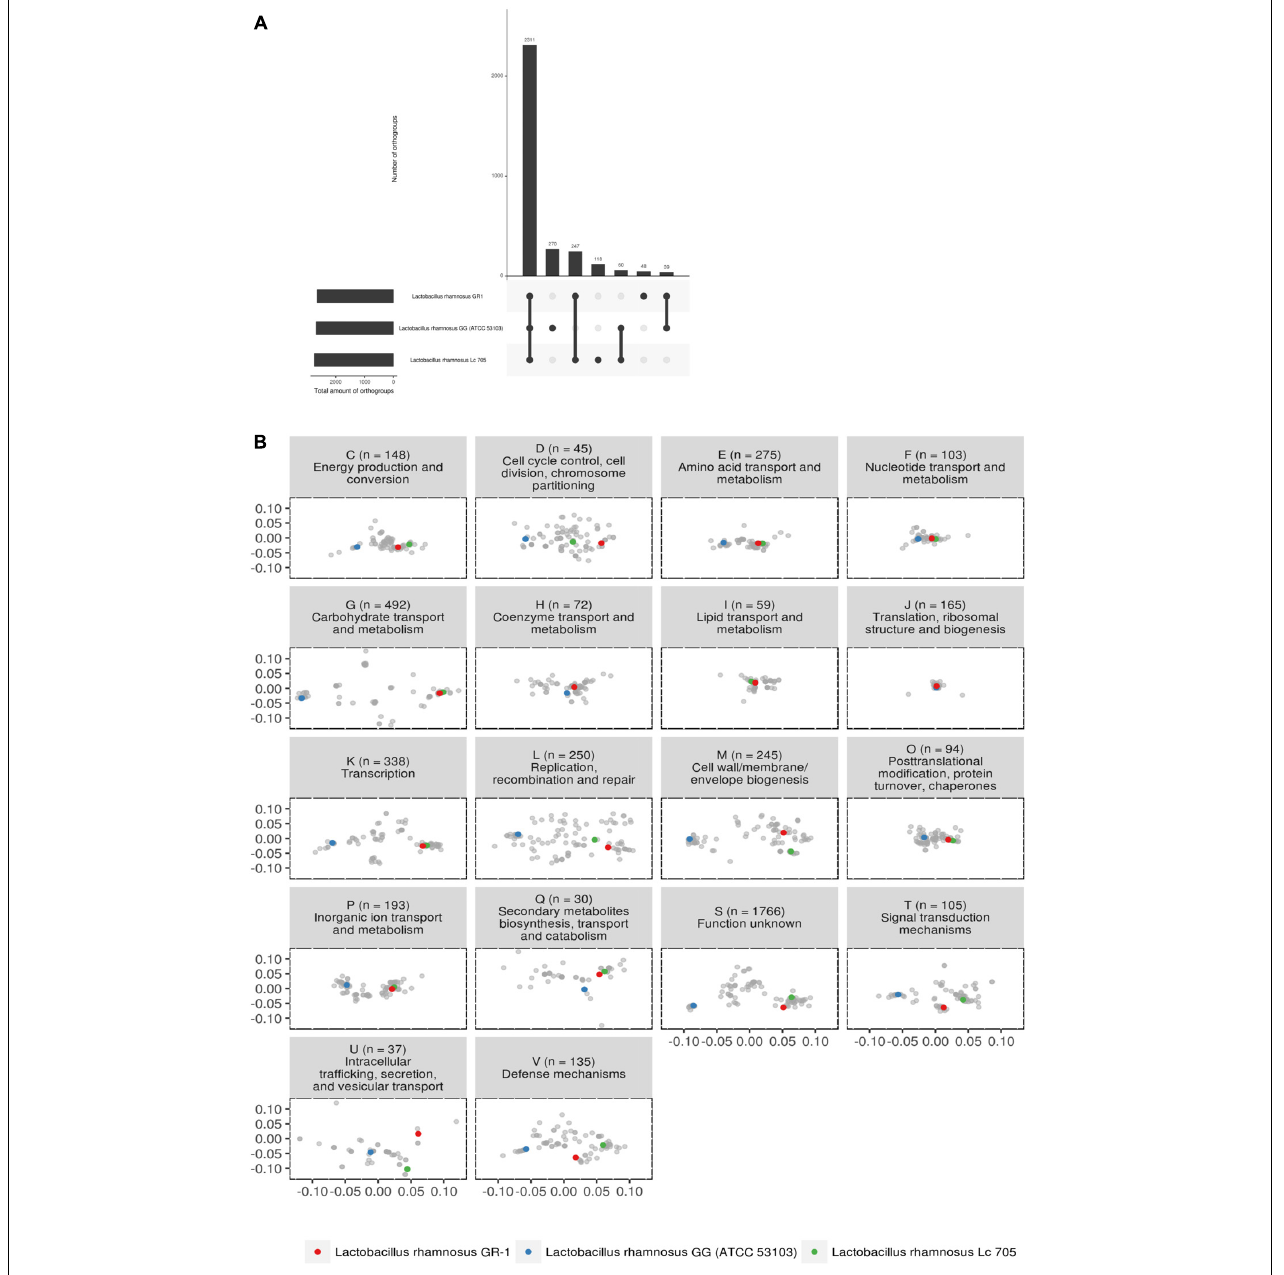
FIGURE 2 | (A) Upset plot comparing all shared orthogroups of the three studied probiotic strains. (B) PCoA of predicted functional capacity of all L. rhamnosus strains based on mapping of all orthogroups to the eggNOG database (v4.5) (Huerta-Cepas et al., 2016). Each letter represents a different functional category, as defined above each plot together with the amount of orthogroups used for that functional category. Some orthogroups mapped to multiple functional categories. The majority of the orthogroups (1,766 of them) mapped to category S (function unknown).